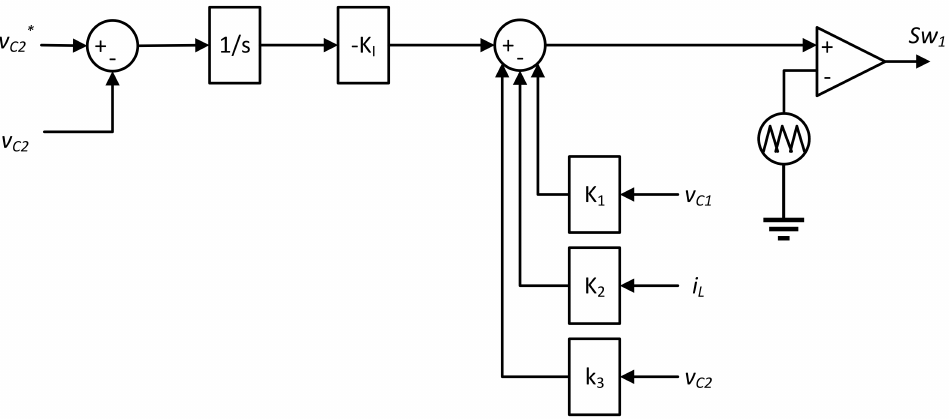
Figure 6. Feedback state controller